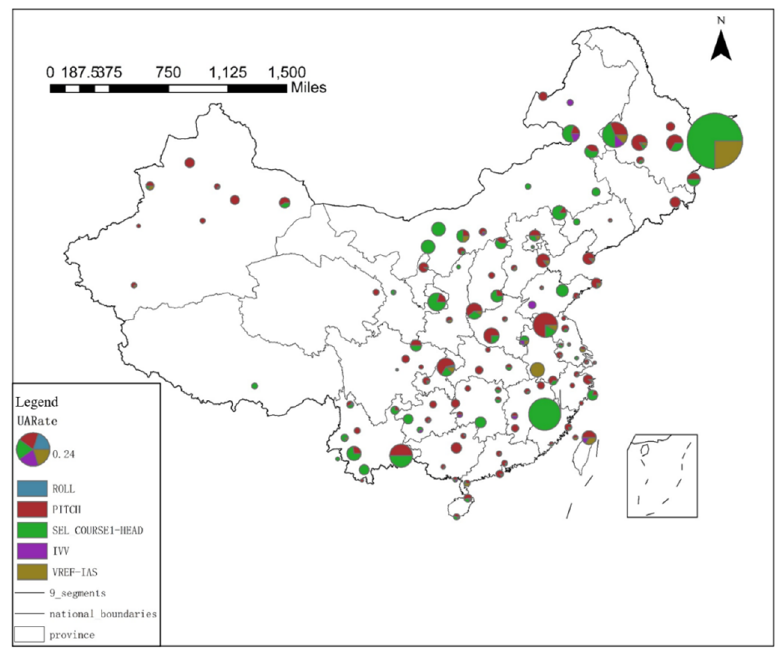
Figure 3. Different causes of UA events for different airports. Figure 3. Di ff erent causes of UA events for di ff erent